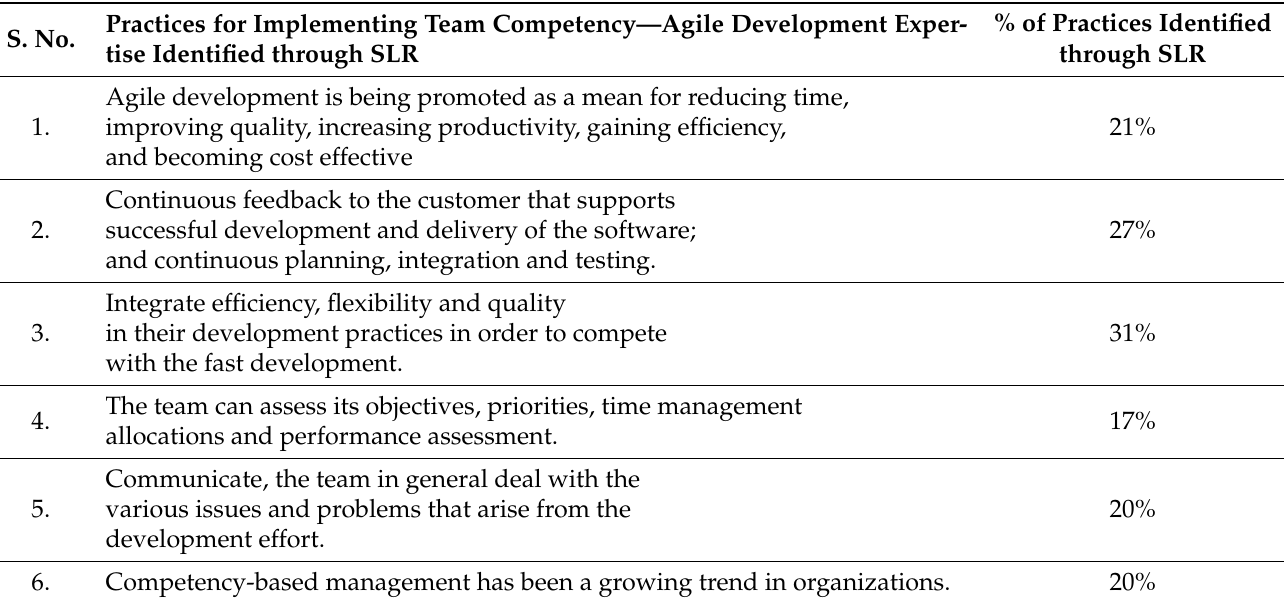
Table 7. Practices for implementing team competency—agile development